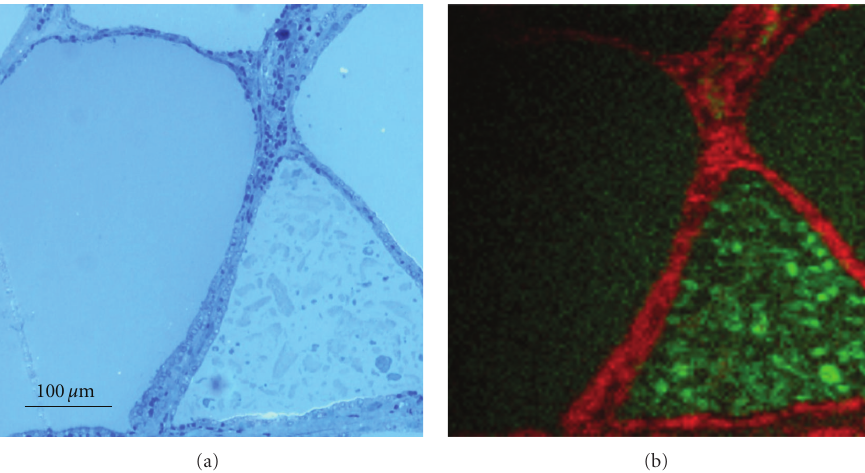
Figure 1: Light microscopy image (a) and TOF-SIMS image (b) of the tissue section from the PTU pretreated patient. The green in the TOF- (signal from cell membranes). Iodine signals were mainly found within SIMS image represents the signal from iodine and the red marks PO − 3 the follicle lumina but also in some areas outside the follicles, presumably in the thyrocytes. The iodine concentration was inhomogeneously distributed within some follicle lumina.